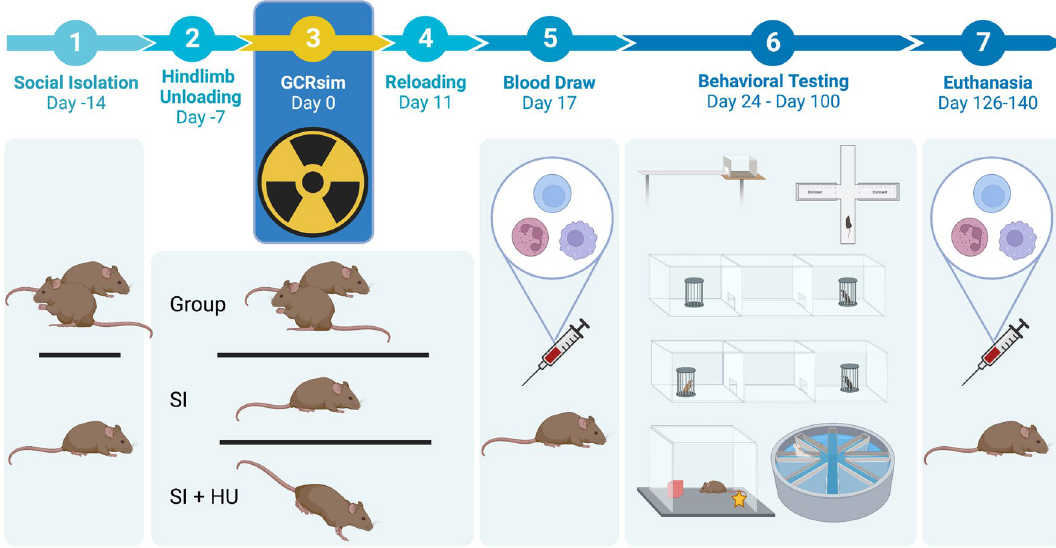
Figure 1. Experimental Design. Days are relative to GCRsim exposure, designated Day 0. On Day-14, animals were split into group housing and social isolation (SI) housing. On Day-7, socially isolated animals in the SI + HU group began hindlimb unloading (HU). GCRsim dose (0 cGy or 50 cGy) was delivered in one exposure on Day 0. All animals were loaded into the beam line housing array for dose delivery. SI + HU animals remained in hindlimb unloading posture. On Day 11, SI + HU animals were reloaded, and given a recovery period before being shipped from Brookhaven National Lab to UCSF. Blood was collected by tail vein on Day 17, and behavioral testing began with the Balance Beam on Day 24. Behavioral testing continued with EPM, Three Chamber Social Approach, Open Field, NOR, and RAWM, concluding around Day 100. Animals were euthanized around Day 126–140, and blood was collected by cardiac puncture for analysis. Created with BioRender.com.